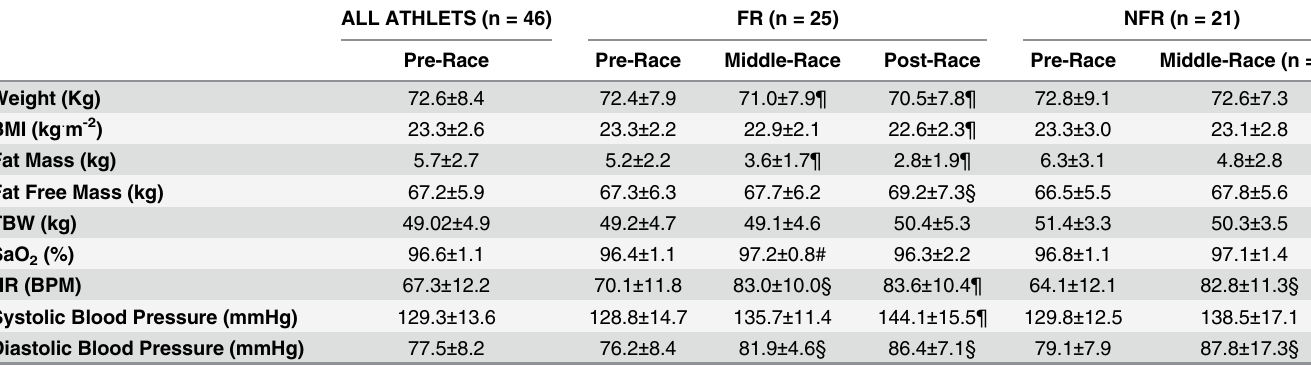
Table 1. Anthropometric and physiological parameters of all athletes.